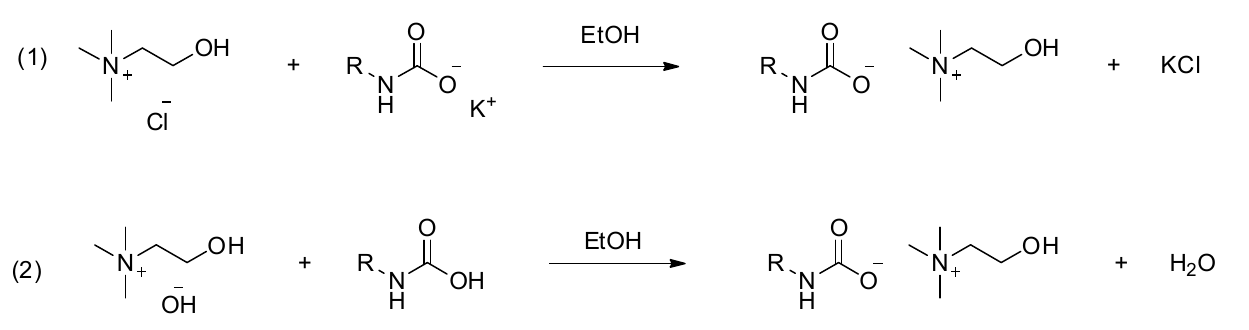
Figure 1. Classification of the Bio-ILs that are mentioned in the literature the period between 2020 and 2022 based on their composition. Choline-based ILs (ChILs), amino-acid-based ILs (AAILs) and choline-amino acid ILs (Ch-AA-ILs).